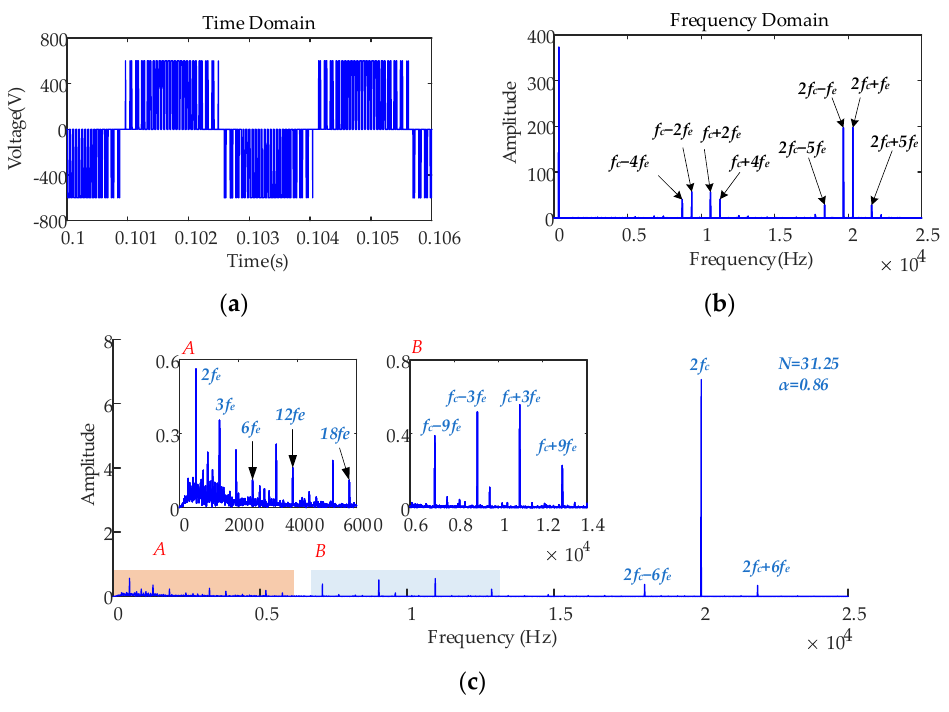
Figure 10. Voltage harmonic characteristics and electromagnetic torque characteristics caused by SVPWM: ( a ) time domain of output line voltage; ( b ) frequency domain of output line voltage; ( c ) frequency domain of electromagnetic torque.